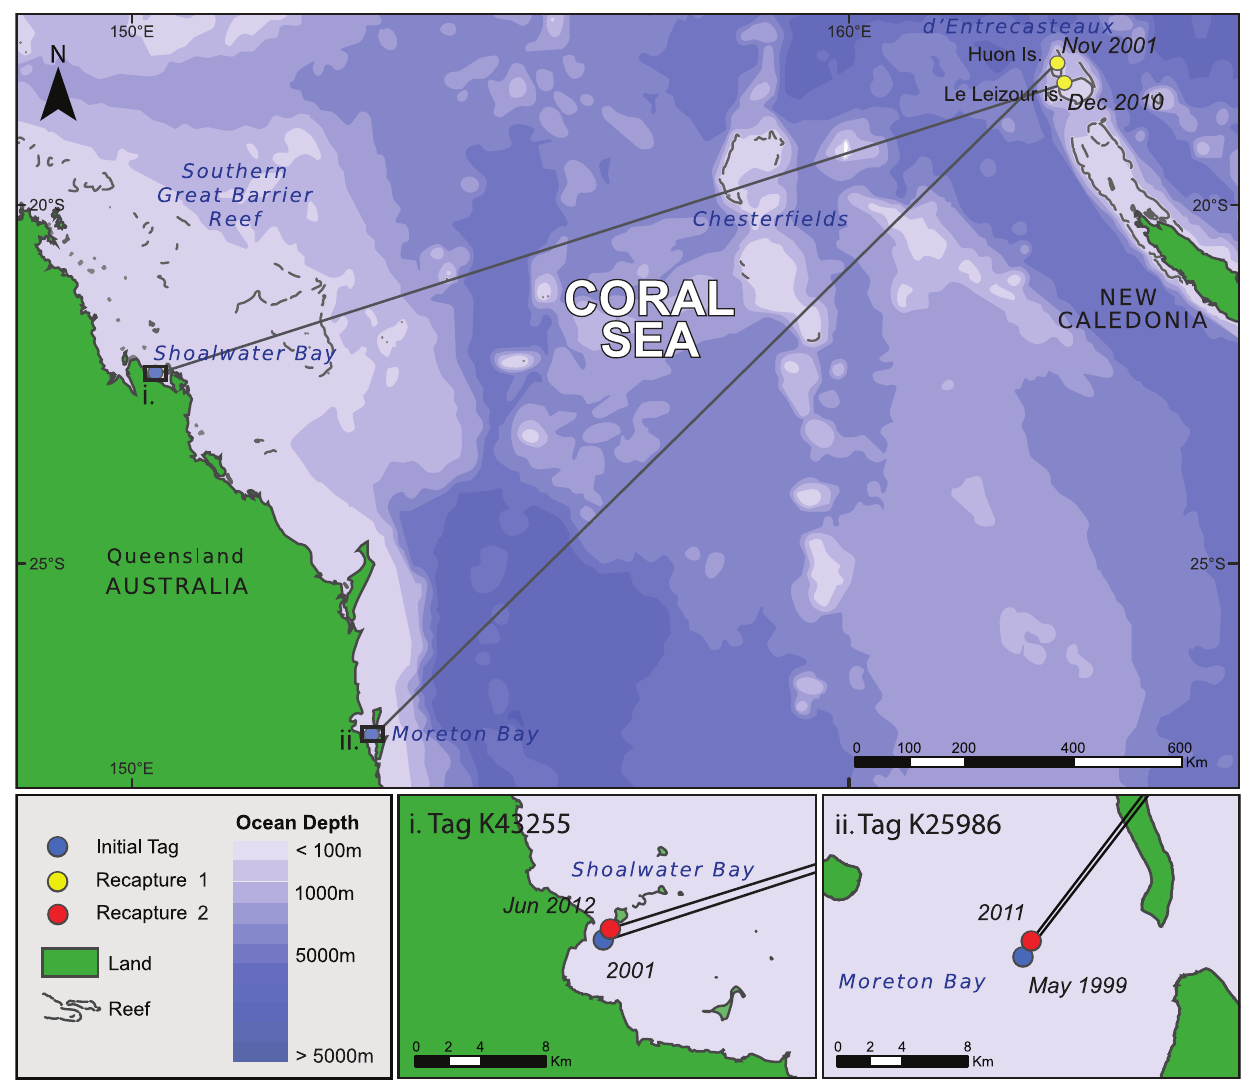
Figure 4. Foraging site fidelity recorded by two females C.mydas originally tagged in Australia, found nesting in New Caledonia and recaptured in subsequent years back at their respective feeding grounds.